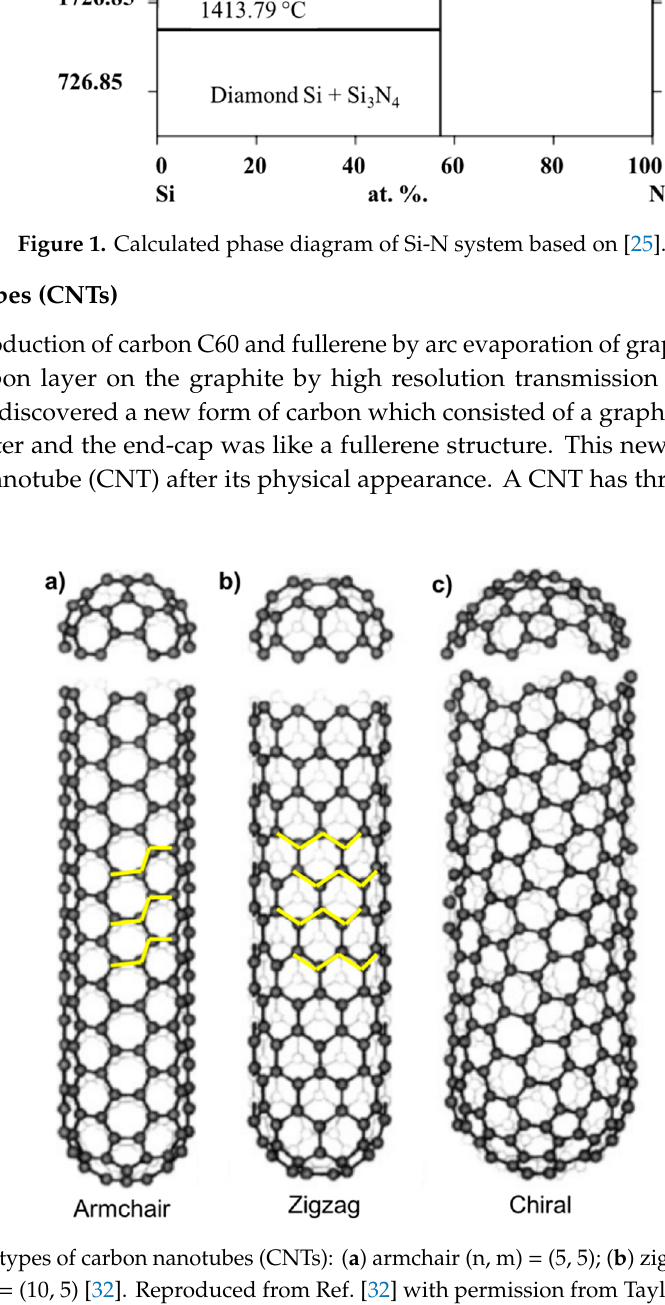
Figure 2. Three types of carbon nanotubes (CNTs): ( a ) armchair (n, m) = (5, 5); ( b ) zigzag (n, m) = (9, 0); ( c ) chiral (n, m) = (10, 5) [32]. Reproduced from Ref. [32] with permission from Taylor and Francis.